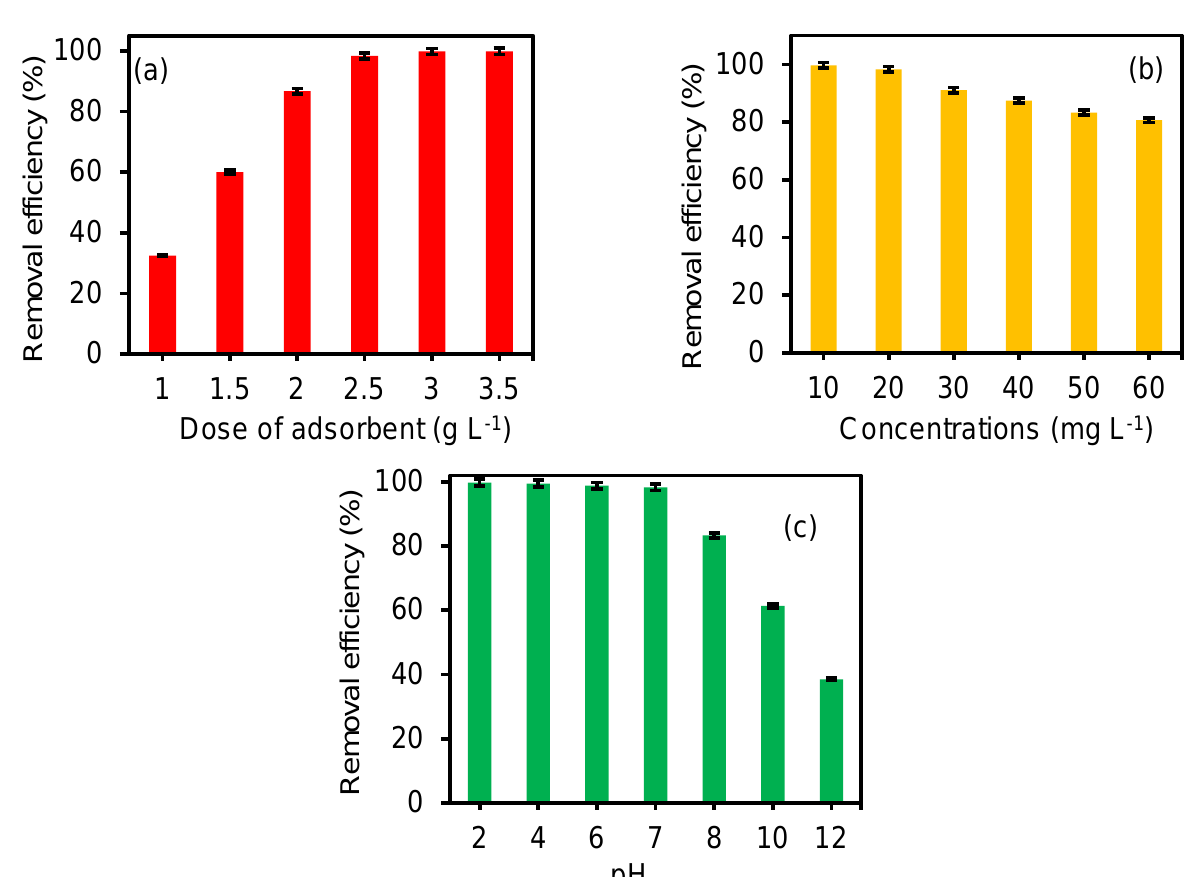
Figure 4. Effect of ( a ) adsorbent dose, ( b ) dye concentration, and ( c ) solution pH on the performance of Cu-ZnBO-Cp-CT for CR removal. (Experimental conditions: Adsorbent dose = 2.5 g L −1 ; Contact time = 135 min; Agitation speed = 200 rpm; Solution pH = 7; CR Concentration = 20 mg L −1 ; Temperature = 30 °C).